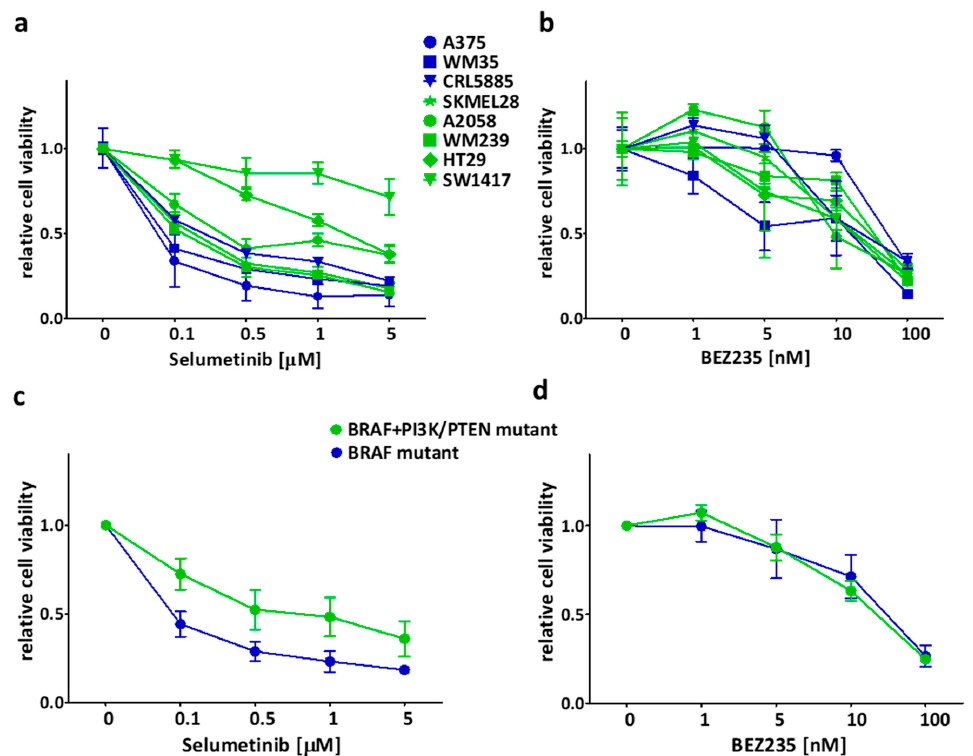
Figure 1. Short term (72 h) effect of selumetinib and BEZ235 on the cell viability (SRB assay). ( a , b ) Selumetinib was more effective on BRAF mutant cell lines (blue) than on BRAF + PI3K/PTEN mutant cell lines (green). After treatment with BEZ235, sensitivity difference was not detected in the mutational groups. ( c , d ) Average cell viability upon treatment with selumetinib or BEZ235 in the two mutational groups. Data is shown as mean ± SEM from at least three independent